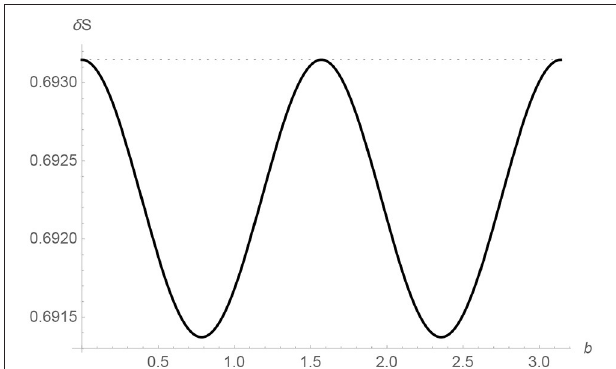
FIGURE 4 | The curve represented by a thin line is the entropy jump δ S as a function of b in Planck units for γ is apparent. The entropy is periodic for b ℓ p dotted line represents the maximum possible entropy which is log[2] in our